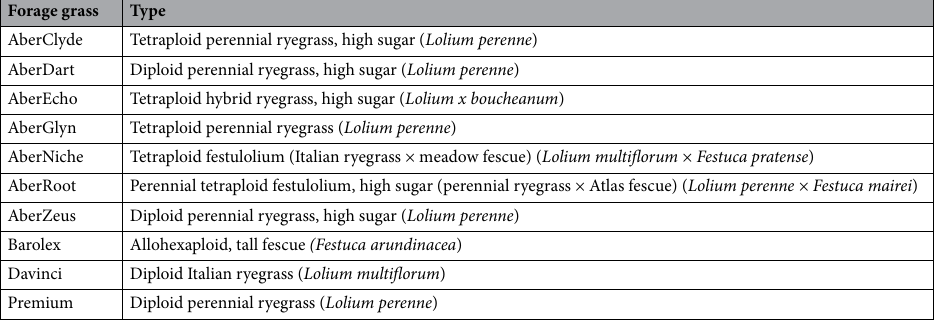
Table 1. Forage grass